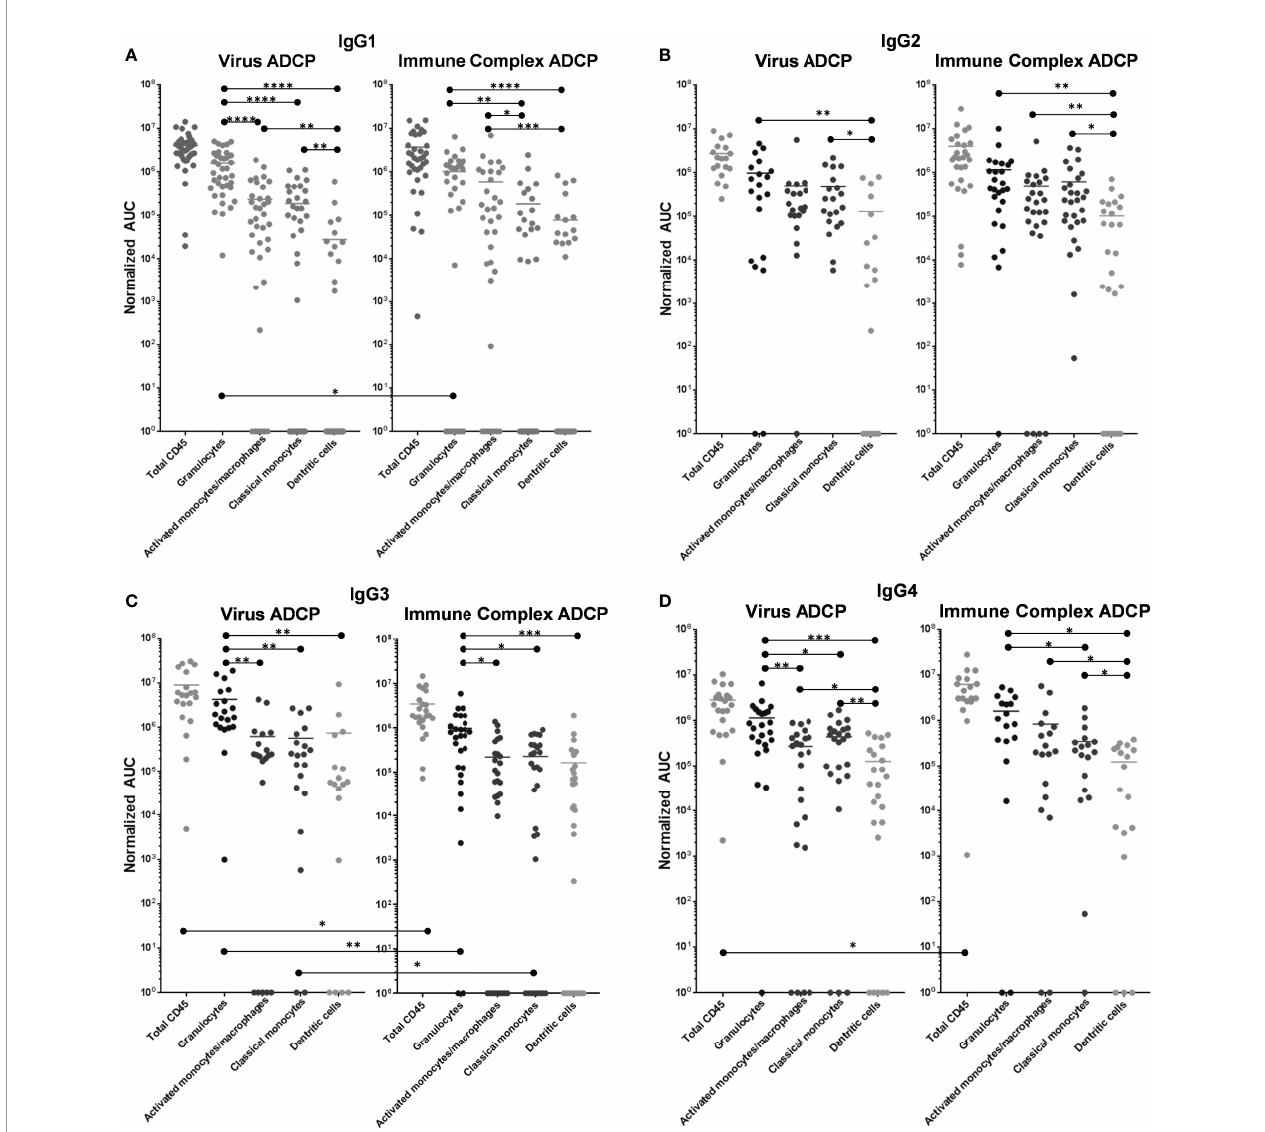
FIGURE 4 | ADCP activity of 246-D-opsonized virus and ICs as compared by effector cell type. (A) IgG1 data. (B) IgG2 data. (C) IgG3 data. (D) IgG4 data. ADCP was performed as described above. ADCP scores at each mAb dilution were plotted using GraphPad Prism and Area under the Curve (AUC) values were calculated for each experiment. AUC scores were normalized by subtracting those obtained for each cell type using the irrelevant anthrax mAb 3865 of the same class. Each data point represents cells from a unique milk sample. Mean AUC are shown. Two-tailed Mann-Whitney tests were used to compare data. ****p < 0.0001; ***0.0009 > p > 0.0001; **0.009 > p > 0.001; *0.05 > p >